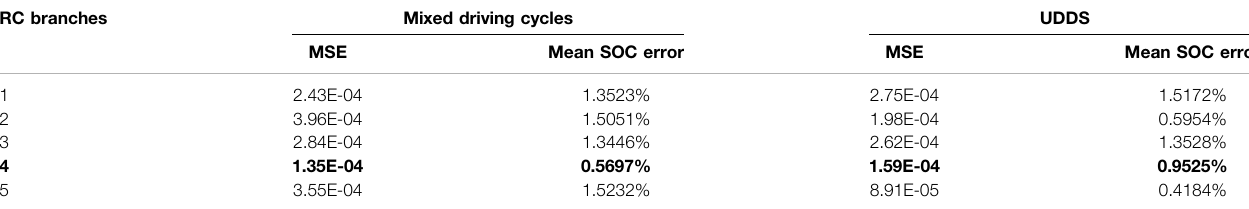
TABLE 17 | Augmented ECM-based AEKF with 20% random